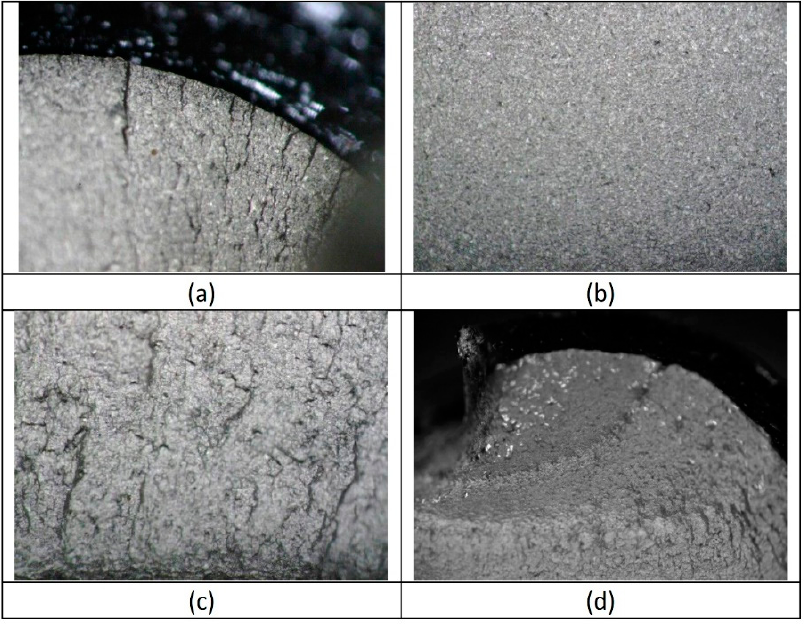
Figure 11. Fracture surface of the bolts: ( a ) multiple initiation sites and ratchet marks due to crack surface convergence; ( b ) relatively smooth surface of stable crack growth; ( c ) rough fracture surface; ( d ) shear lip.